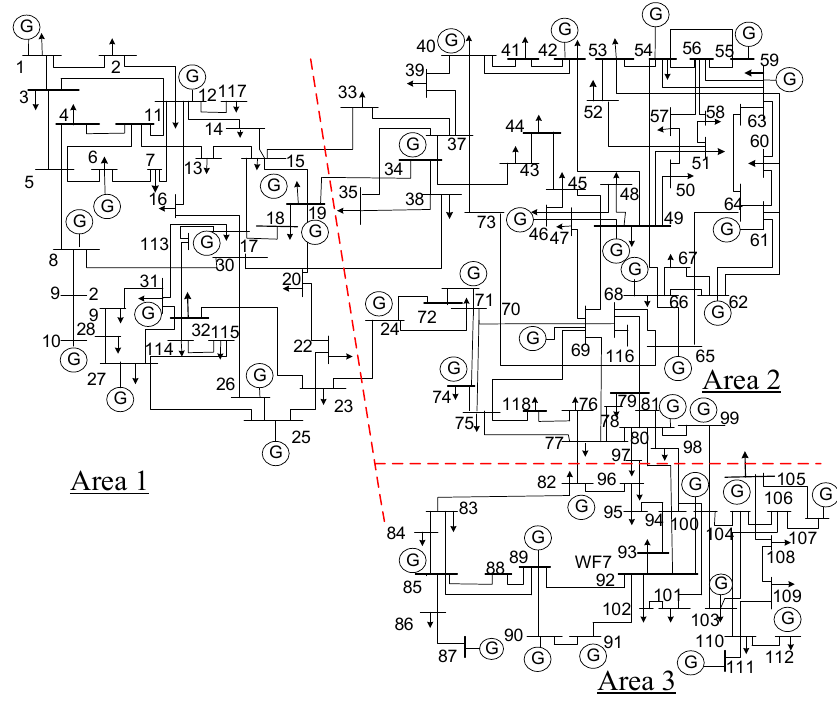
Figure 9. IEEE 118-bus system with three areas. Figure 9. IEEE 118 ‐ bus system with three areas. Table 7. ATC and Gen. Dispatch Results in IEEE 118-bus Table 7. ATC and Gen. Dispatch Results in IEEE 118 ‐ bus system.